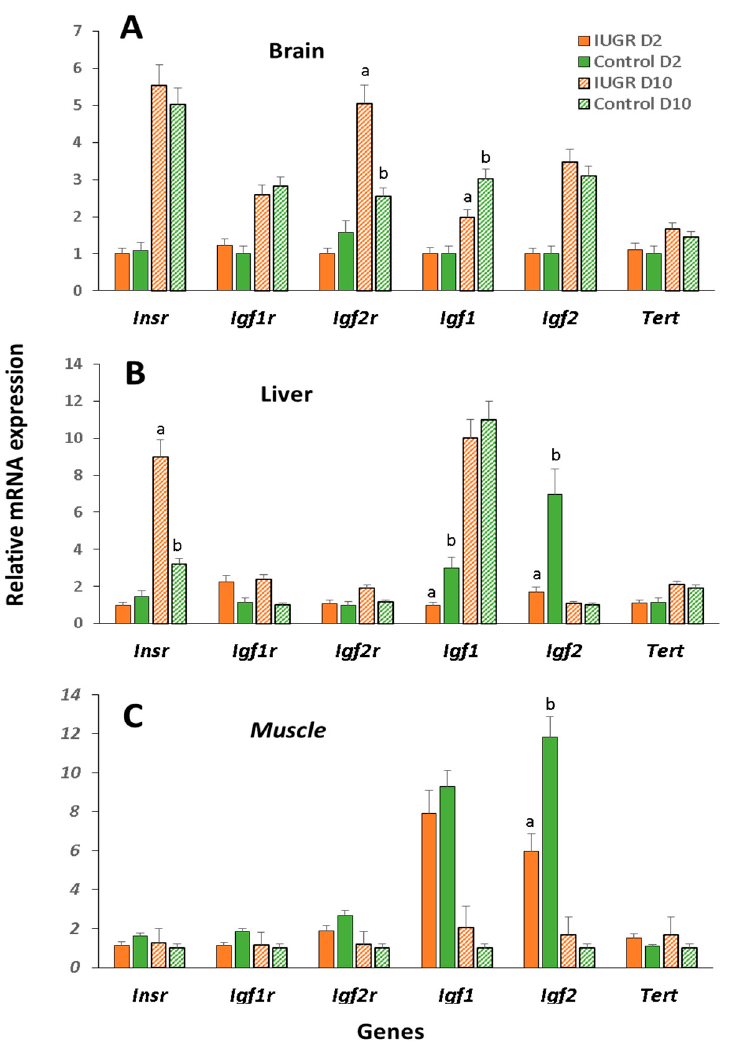
Figure 3. Relative mRNA expression of insulin receptor and insulin-like growth factors and receptors in IUGR B6 female mice. Relative expression levels recorded on Day 2 and Day 10 in the IUGR and control group in brain ( A ), liver ( B ), and muscle ( C ). Data expressed relative to levels recorded for the housekeeping genes Actb and H2afz . Results are provided as the mean ± SD. a,b different letters indicate significant differences between IUGR and control groups on Day 2 or Day 10 of life ( p <